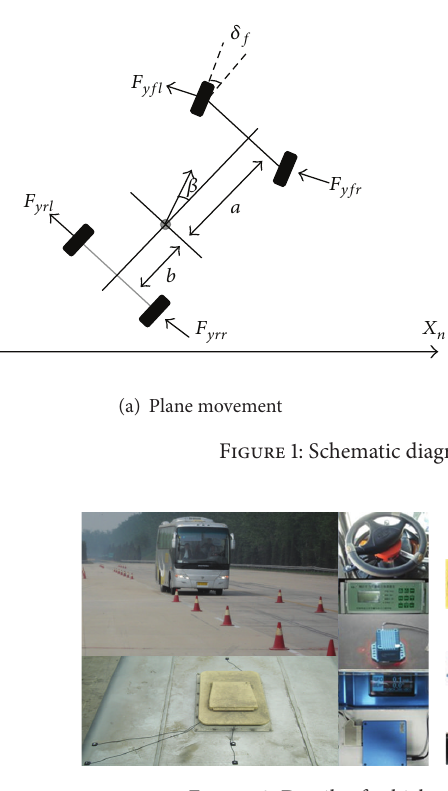
Figure 2: Details of vehicle tests and related equipment.